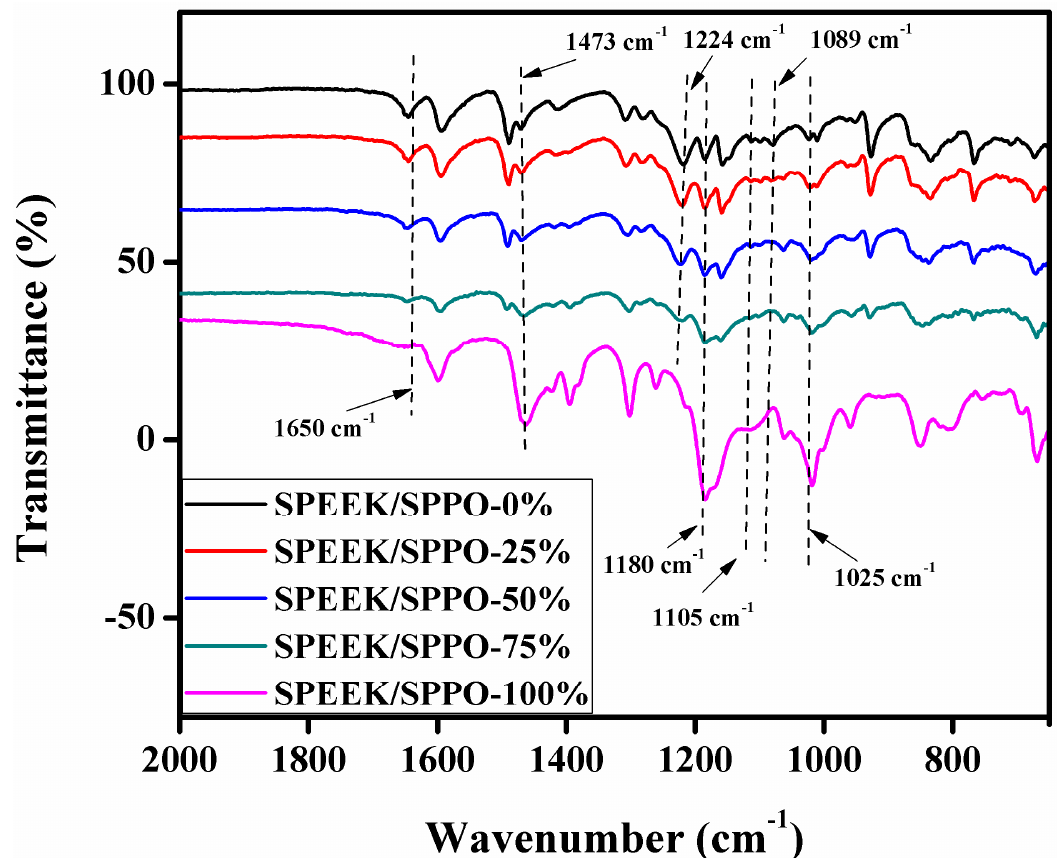
Figure 2. IR spectrums of SPEEK, SPPO and SPEEK/SPPO blended membranes (where 0, 25, 50, 75 and 100% represent the amount of SPPO into the SPEEK/SPPO blended membranes).